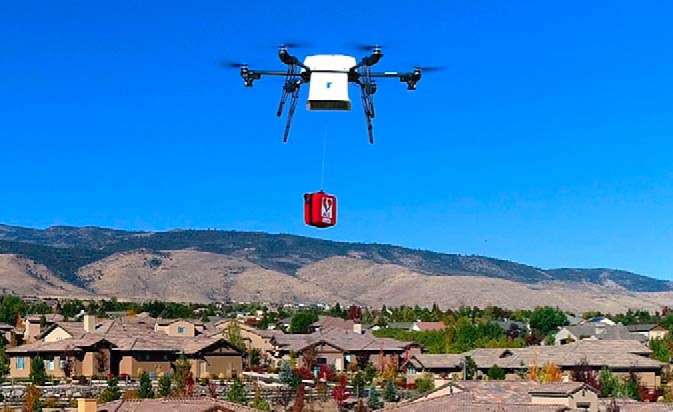
A quadcopter delivers an automated external defibrillator (AED). © 2017/Mollyrose89